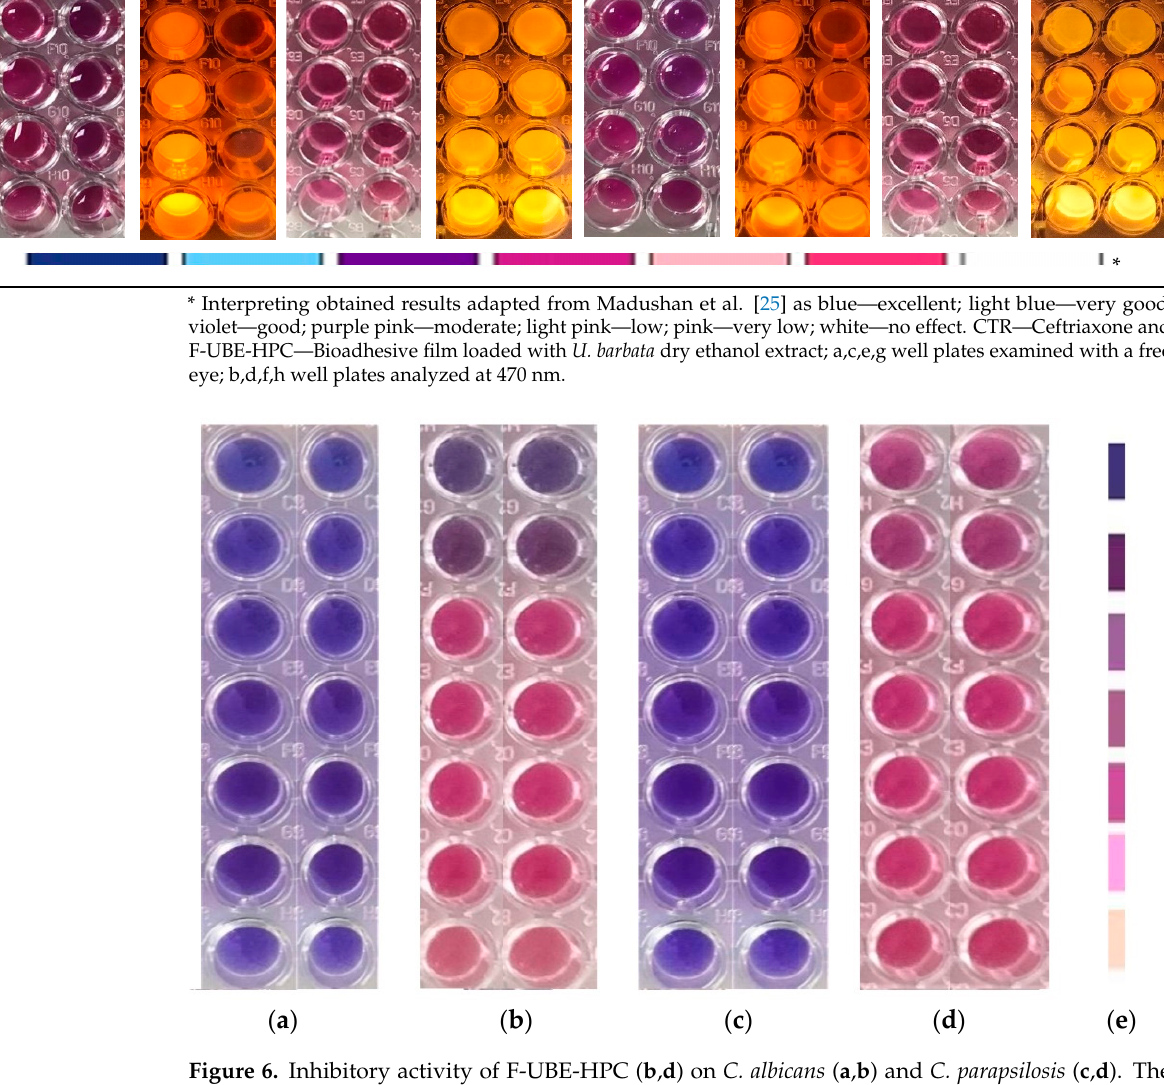
Figure 6. Inhibitory activity of F-UBE-HPC ( b , d ) on C. albicans ( a , b ) and C. parapsilosis ( c , d ). The results were compared with Terbinafine ( a , c ) as an antifungal drug. ( e ) Results interpretation adapted from Bitacura et al. [27], as follows: blue—cells are dead; violet–blue—cells are partially dead; violet—cells are alive, no proliferation; light-violet—low proliferation; dark pink—moderate proliferation; pink—fast proliferation; light pink—very fast proliferation. F-UBE-HPC—bioadhesive oral film loaded with U. barbata dry ethanol extract.